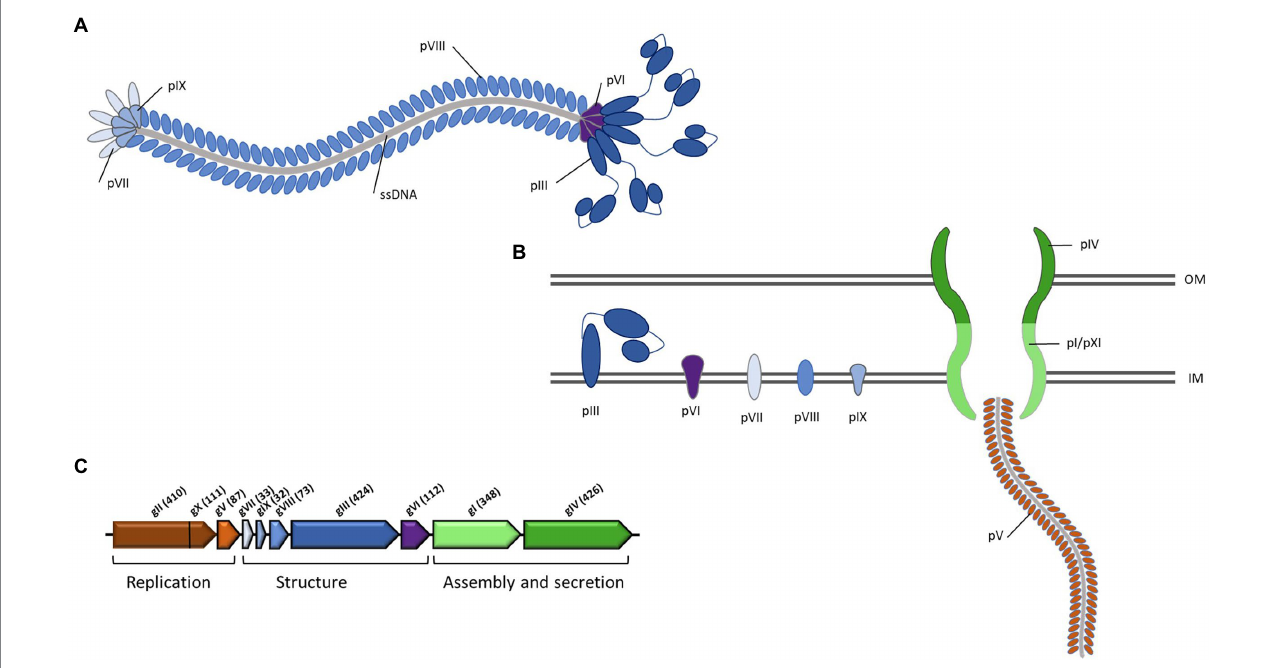
FIGURE 3 General schema of genes and genome organization of filamentous phages. The genes and the proteins they encode are color-coded according to function, where brown indicates replication; blue indicates structural; green indicates assembly and secretion. (A) the mature virion; (B) the virion within the bacterial host cell; associated phage structural, assembly and secretion proteins are embedded within the bacterial membrane; (C) genome organization of the model Ff filamentous phage, with the standard gene notations of gI to gX. Figure adapted from Mai-Prochnow et al.